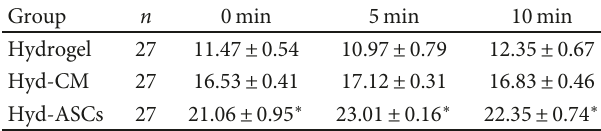
Table 1: Blood perfusion value in each group (mean ±